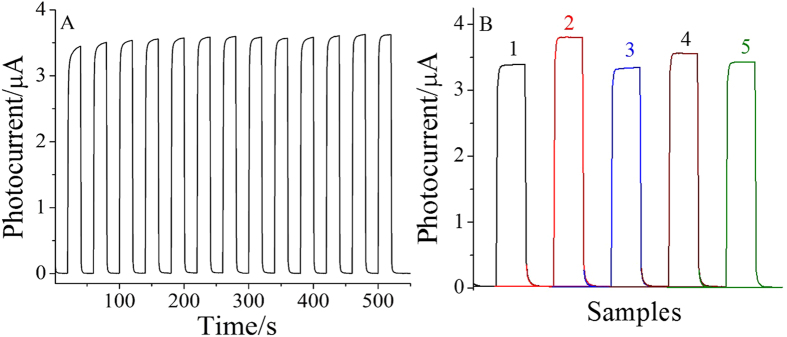
The stability of the immunosensor incubated with 5 ng/mL CEA under several on/off irradiation cycles for 550 s (A) and the selectivity of the immunosensor (B). 5 ng/mL CEA (1), 5 ng/mL CEA + 50 ng/mL PSA (2), 5 ng/mL CEA + 50 ng/mL H-IgG (3), 5 ng/mL CEA + 50 ng/mL BSA (4), 5 ng/mL CEA + 50 ng/mL glucose (5).